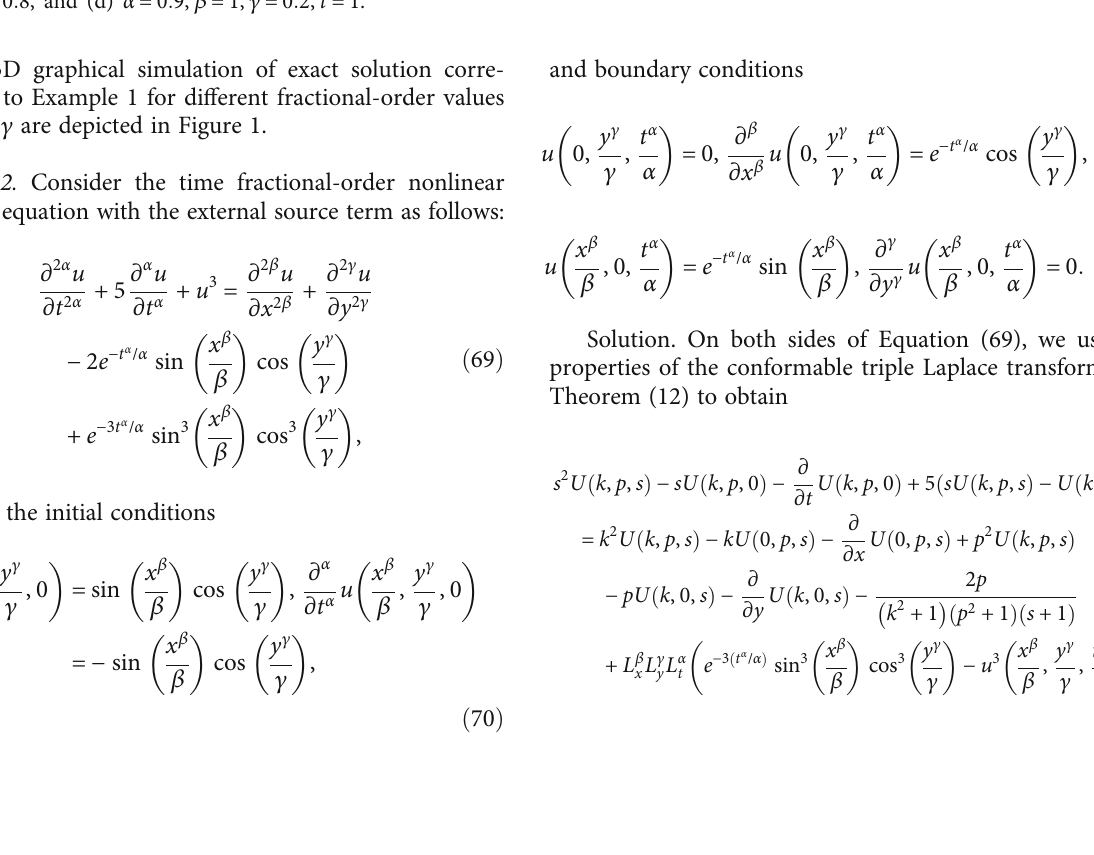
Figure 1: 3D solution plots of Example 1 at (a) α = 0 : 5, β = 0 : 8, γ = 0 : 6, t = 0 : 1 , (b) α = 0 : 6, β = 0 : 9, γ = 0 : 5, t = 0 : 4 , (c) α = 0 : 8, β = 0 : 5, γ = 0 : 7, t = 0 : 8 , and (d) α = 0 : 9, β = 1, γ = 0 : 2, t = 1